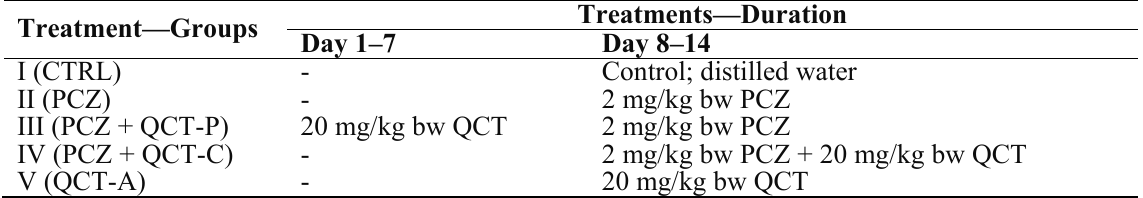
Table 1. Experimental